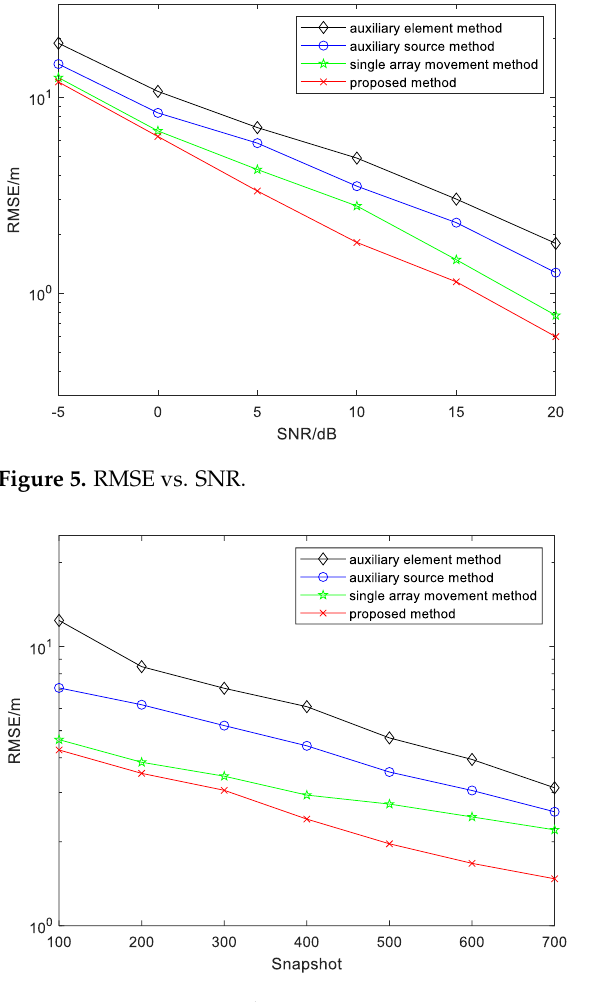
( b ) Figure 4. ( a ) Scatter plot without calibration; ( b ) scatter plot with the proposed method. Furthermore, root mean square error (RMSE), regarded as a benchmark, is used to assess the localization performance of different methods. The definition of RMSE is as follows: